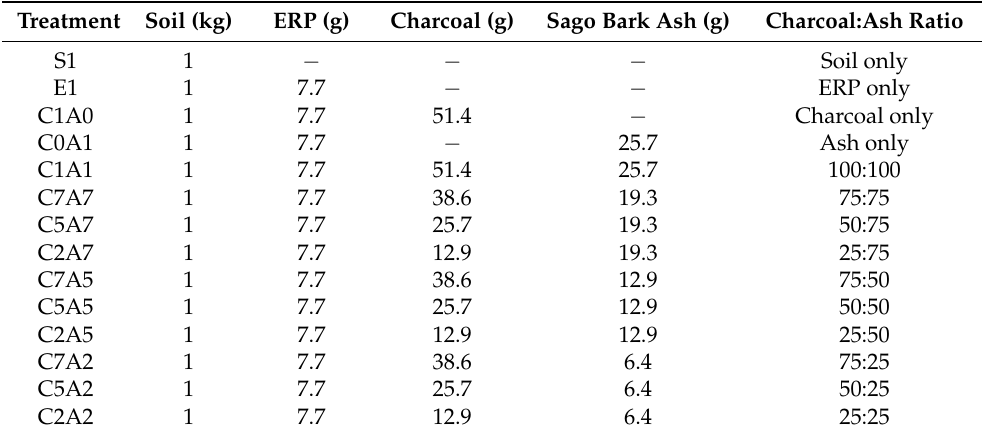
Table 3. Treatments evaluated in leaching